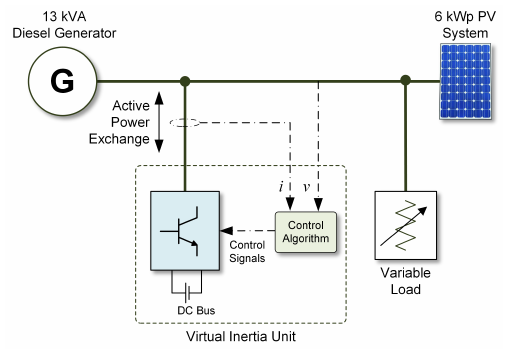
Figure 11. Schematic diagram of the virtual inertia simulation benchmark.